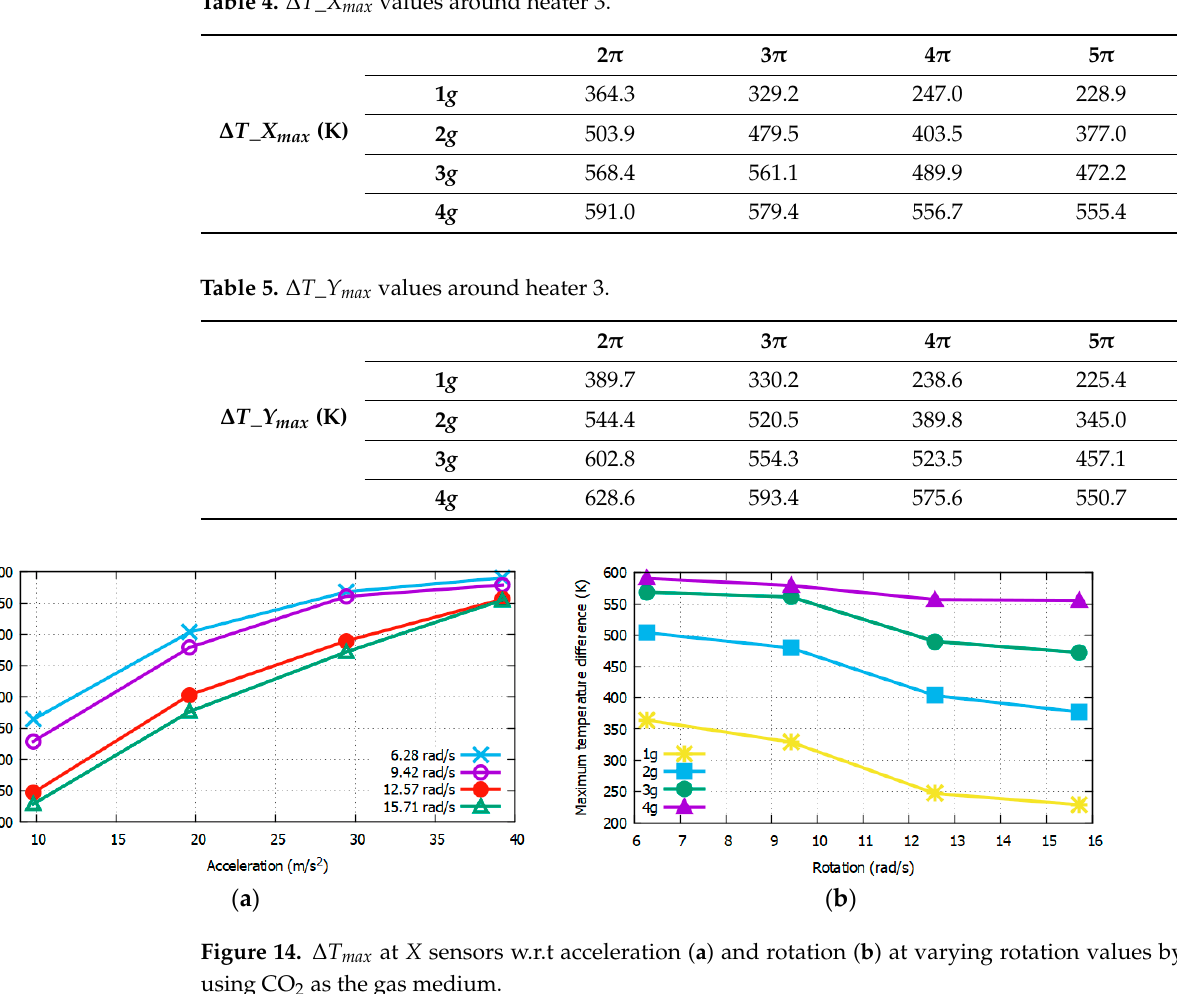
Table 4. ∆ T_X max values around heater 3.